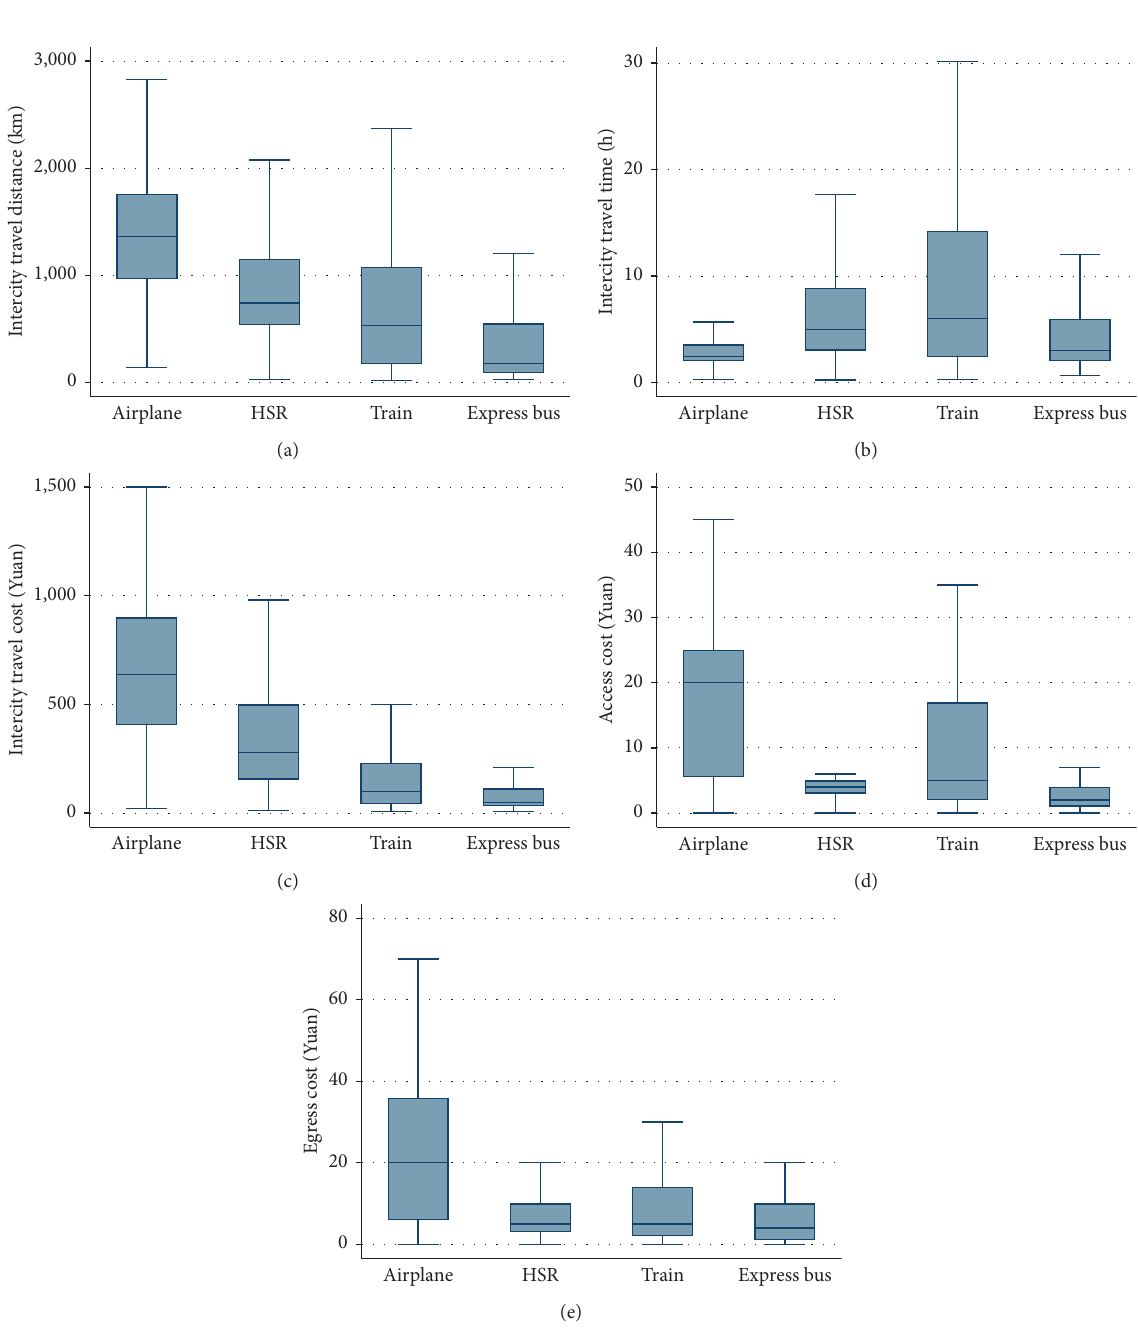
Figure 1: Description of continuous variables. (a) Intercity travel distance. (b) Intercity travel time. (c) Intercity travel cost. (d) Access cost. (e) Egress